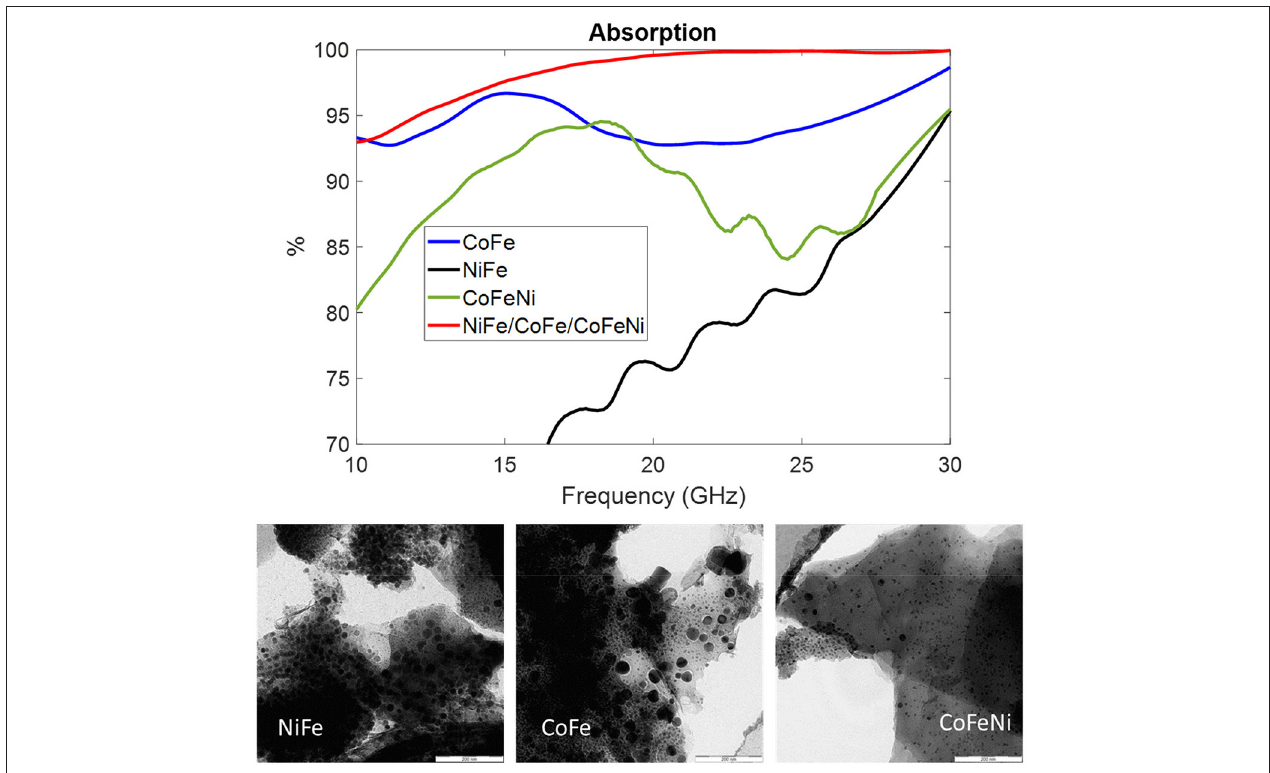
FIGURE 8 | Absorption resulting from a gradient of the saturation magnetization values of magnetic nanoparticles. Bottom line shows TEM images for MNPs considered in this paper. Scale bar is